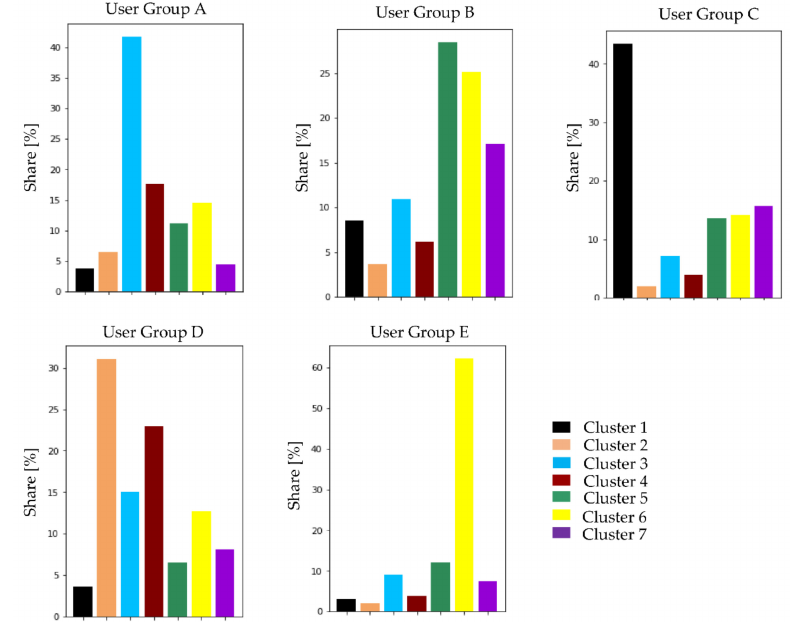
Figure A10. Related Clusters to the k-Means